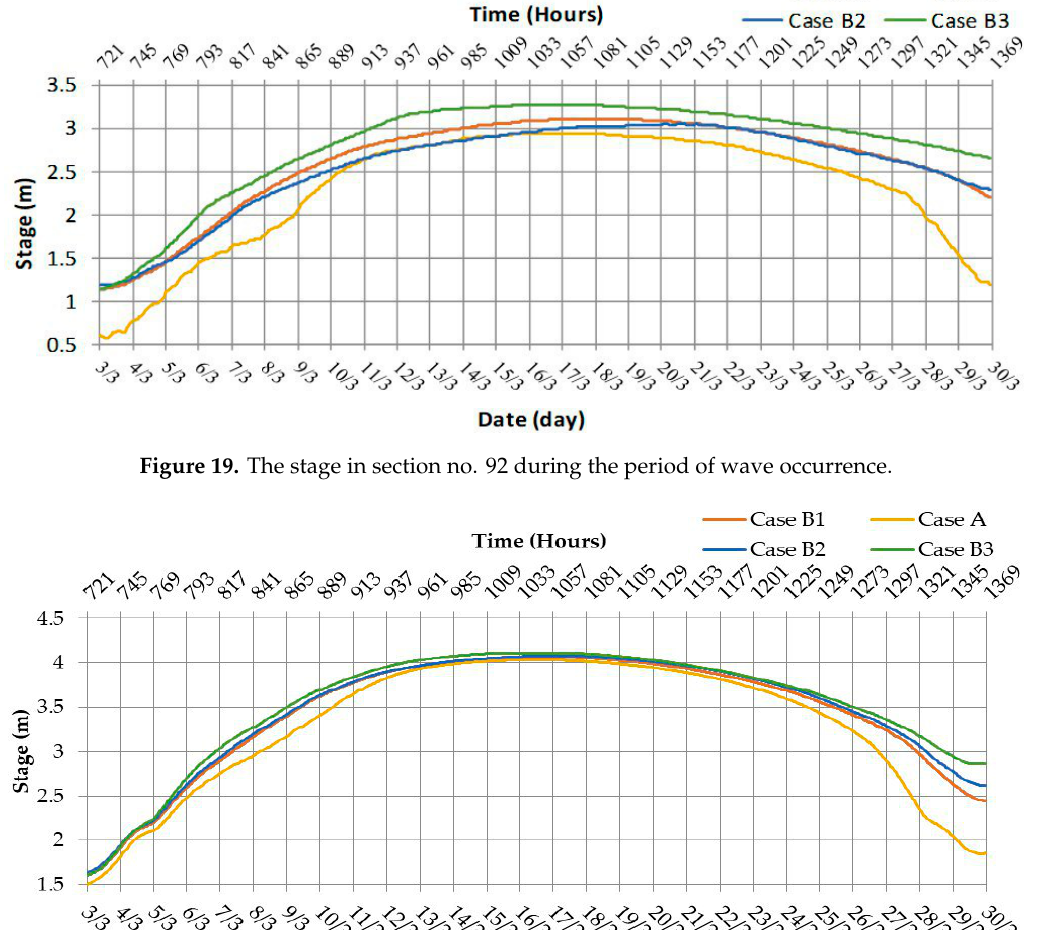
Figure 20. The stage in section no. 115 during the period of wave occurrence.